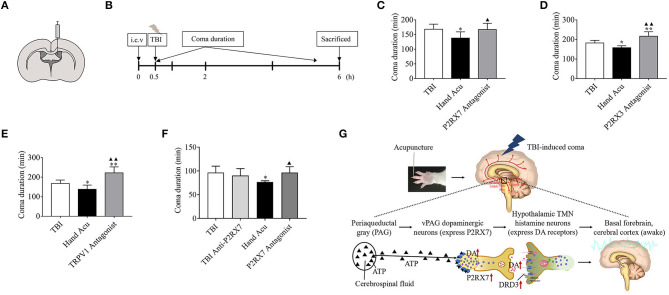
P2RX3, P2RX7, and TRPV1 mediates acupuncture-induced awakening effect in TBI rodents. (A,B) Experimental representation of the lateral intracerebroventricular (i.c.v) and vPAG intranuclear injection of blockers 0.5 h before starting TBI. (C–E) Time duration of the TBI-induced coma in control rats, treated with HTWP acupuncture (hand Acu), or pretreated with intraventricular injection of specific antagonists against (C) P2RX7, (D) P2RX3, or (E) TRPV1 (n = 6/group; one-way ANOVA). (F) Time duration of the TBI-induced coma in control rats, treated with HTWP acupuncture (hand Acu), or pretreated with vPAG intranuclear injection of a specific antagonist against P2RX7 (n = 6/group; one-way ANOVA). Error bars represent mean + SEM; *P < 0.05, **P < 0.01 vs. Sham; ▴P < 0.05, ▴▴P < 0.01 vs. TBI. (G) Scientific hypothesis proposing that HTWP acupuncture activates vPAG dopaminergic neurons to express P2PX7 to enhance dopaminergic connections with the hypothalamic tuberomammillary nucleus histamine neurons (expressing DRD3).